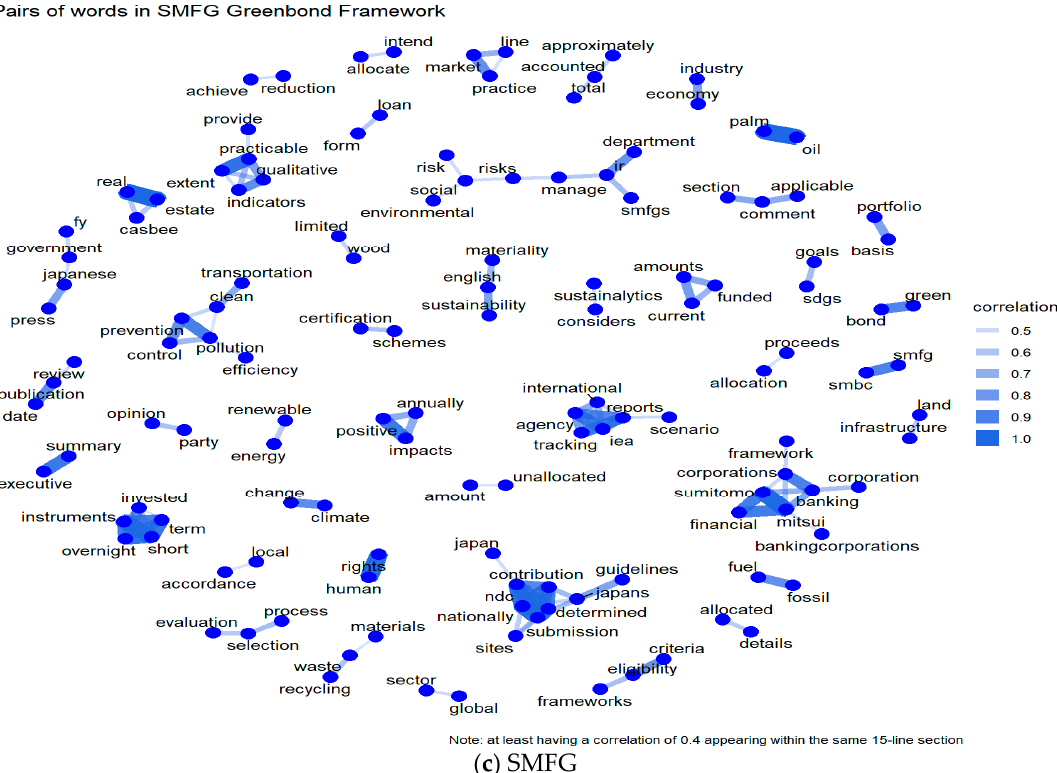
Figure 7. Network matrix for the Japanese guidelines and frameworks .